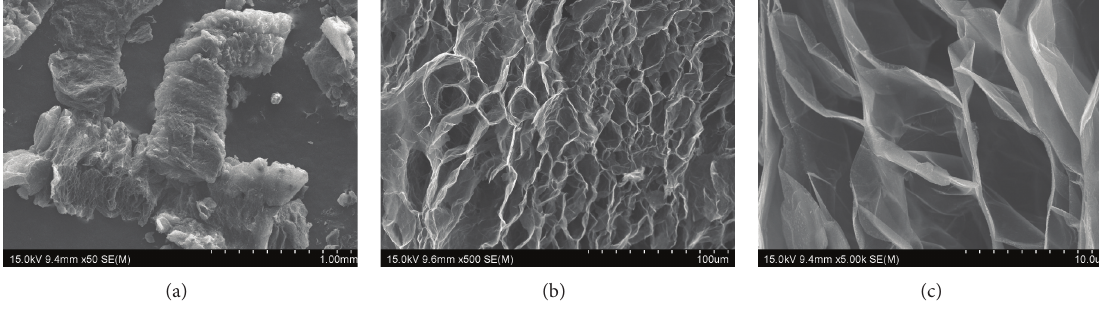
Figure 1: FE-SEM images of the MEG samples.